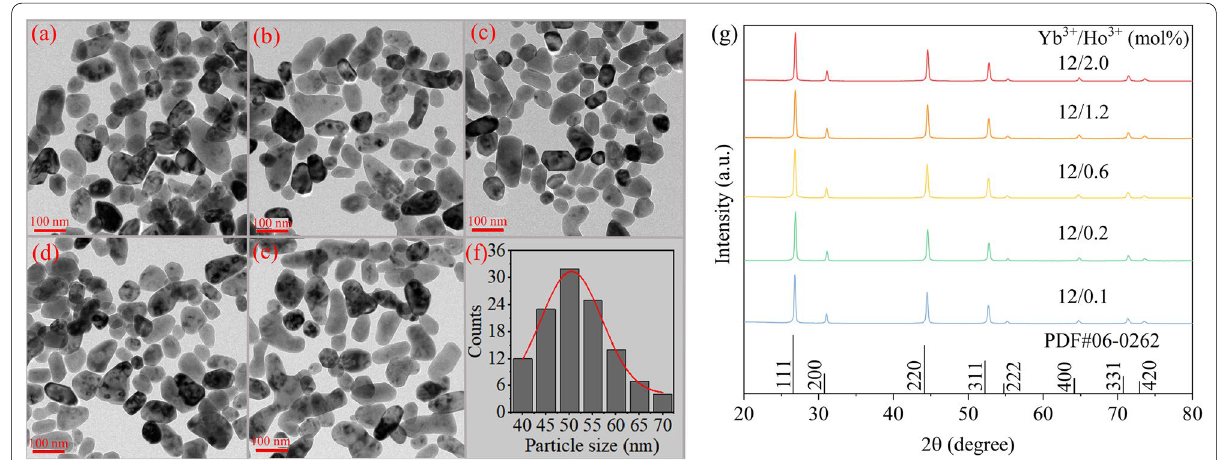
Fig. 1 TEM images of SrF 2 :Yb 3 + /Ho 3 + (12/x mol%) NCs, a x Ho 3 + (12/0.1 mol%) NCs. g XRD patterns of SrF 2 :Yb 3 + /Ho 3 + (12/x mol%) NCs doped with different Ho 3 +